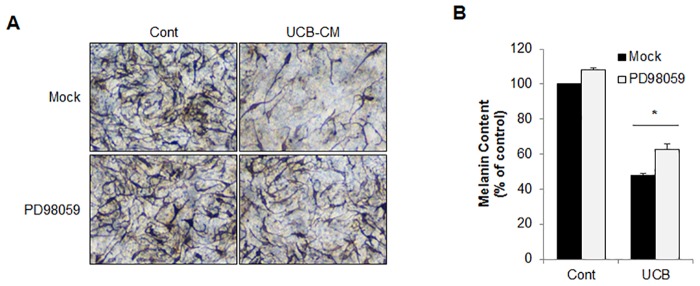
Inhibition of ERK1/2 suppressed anti-melanogenic activity of hUCB-MSC-CM in artificial human skin model.(A, B) The MelanoDerm tissues were treated with hUCB-MSC-CM in the presence or absence of PD98059 for 18 days. Then, the image was captured (A). And the tissues were collected to measure total melanin contents (B). The data were obtained from least three independent experiments and values are presented as the means ± S.E.M. (n>3, * p<0.05).